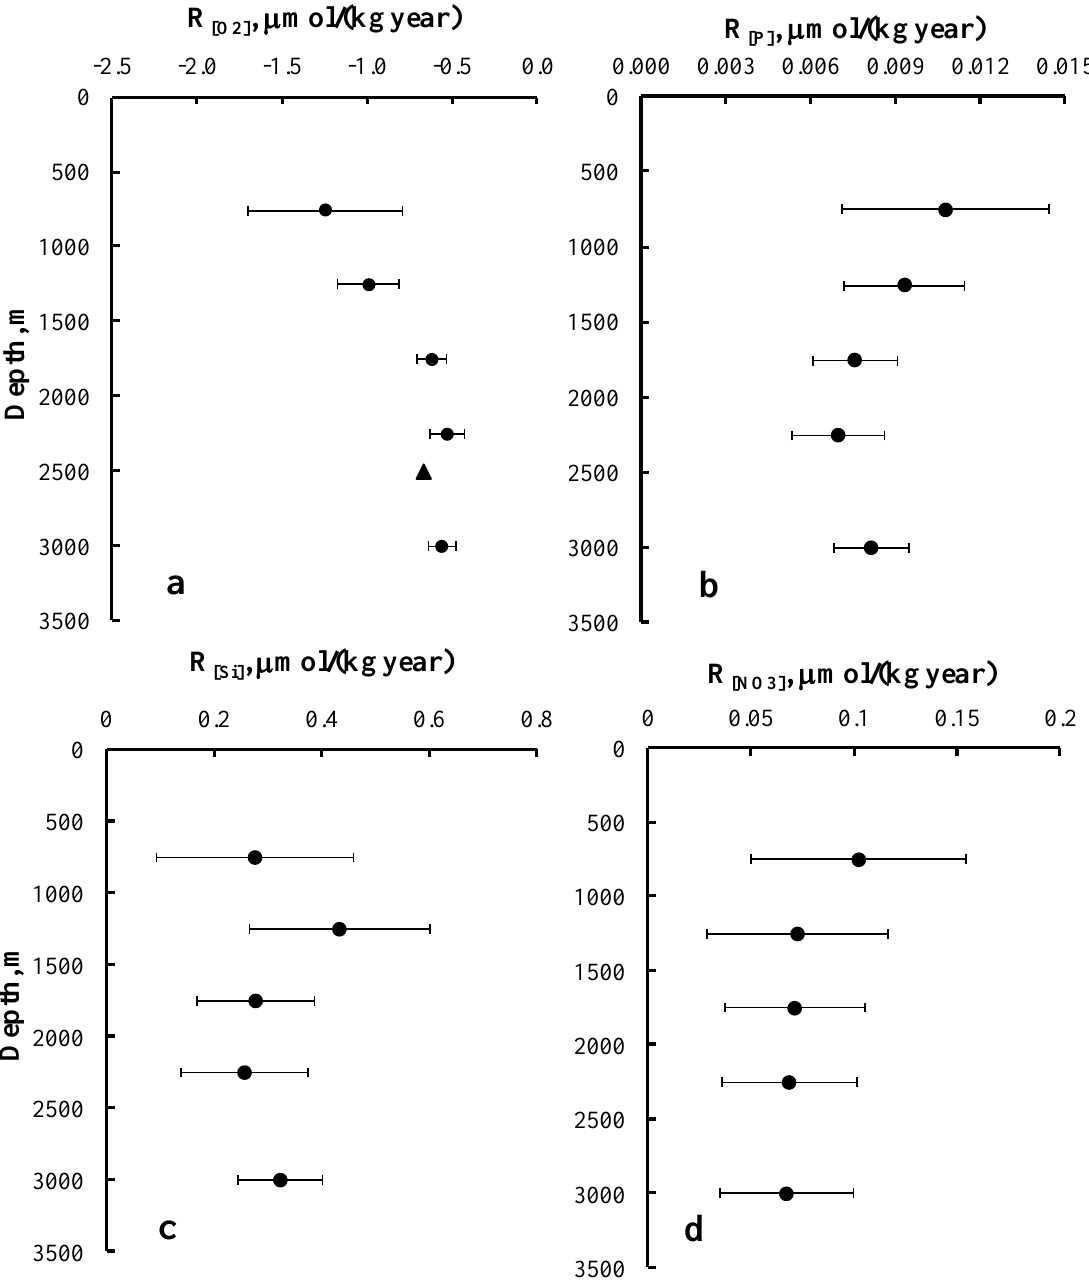
Figure 9. Rates of temporal variability of the averaged hydrochemical parameters in the JES as a function of depth. ( a ) R [O2] , µmol/(kg·year); ( b ) R [P] , µmol/(kg·year); ( c ) R [Si] , µmol/(kg·year); ( d ) R [NO3] , µmol/(kg·year). The triangle denotes the deoxygenation rate estimated by Gamo et al., 2014 [36]. Bars are 3·s.d. of rates estimated by LSM with the 95% confidence interval.